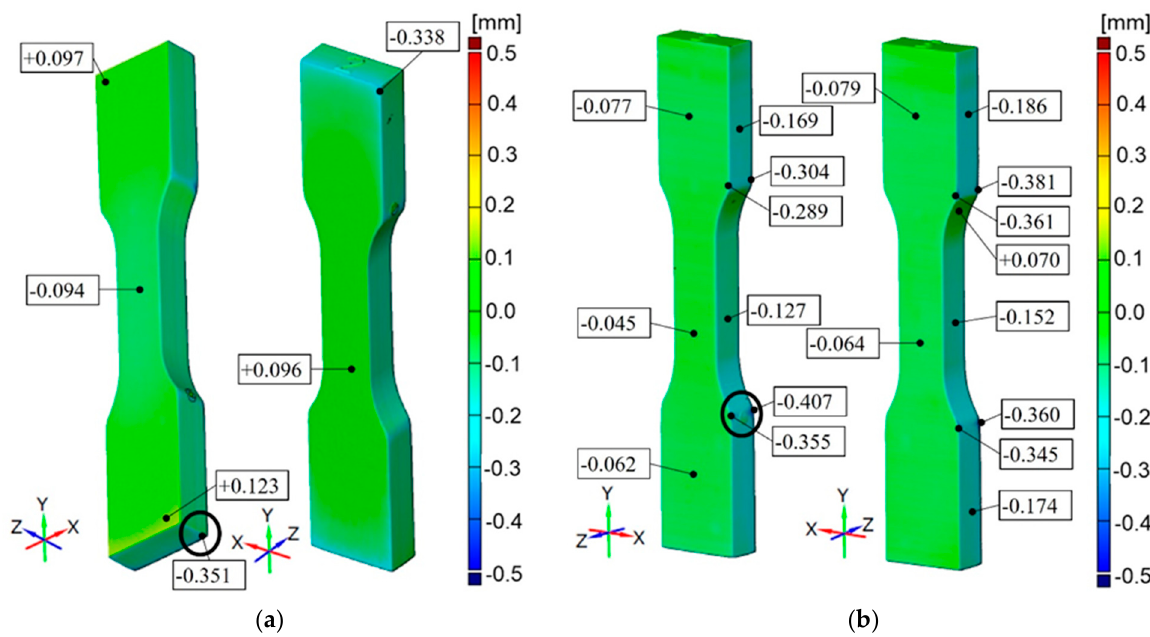
Figure 12. Geometric accuracy [mm] for the specimens made of Rigur material printed with nominal layer thickness 0.016 mm, Objet Connex3 3D printer: ( a ) Raster orientation: horizontal (X-axis), specimen ID: 2; ( b ): Raster orientation: vertical (Z-axis), specimen ID: 5.